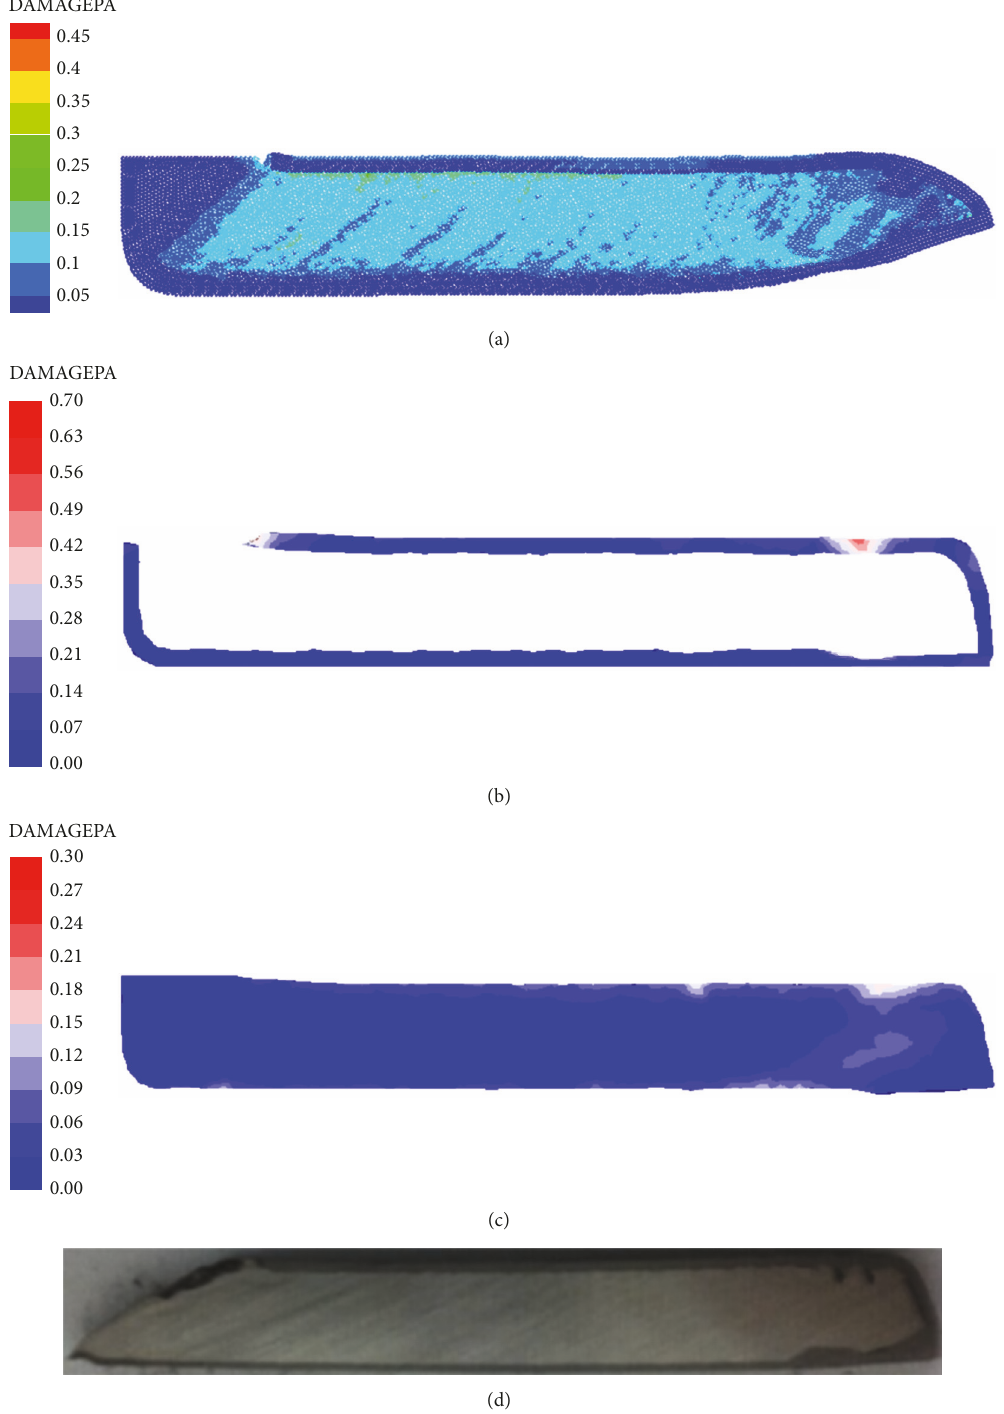
Figure 15: Simulated results of damage value distribution and test results. (a) Computation results based on SPH. (b), (c) Simulation results based on finite element method. (d) Test